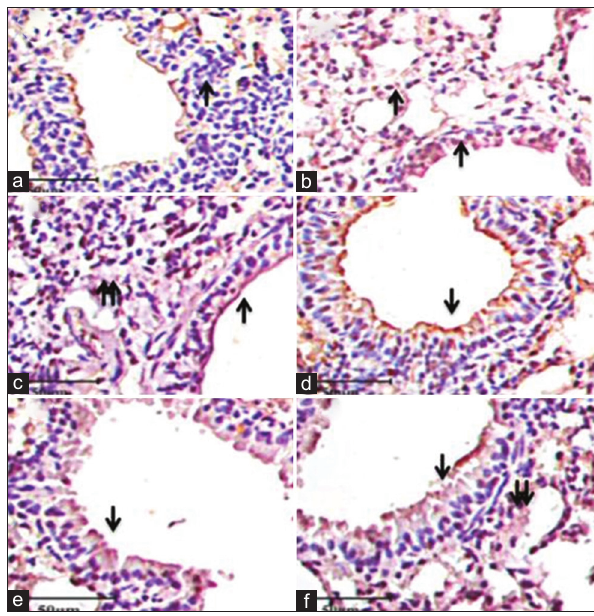
Figure-2: Lung tissue showing expression of toll-like receptor-9 immunopositive reactivity in airways epithelium (single arrow) and alveolar septal cells (double arrow) in control (a), lipopolysaccharide (LPS) (b), indoxacarb (4 mg/kg) (c), indoxacarb (4 mg/kg) and LPS (d) indoxacarb (2 mg/kg) (e) and indoxacarb (2 mg/kg) and LPS (f) groups